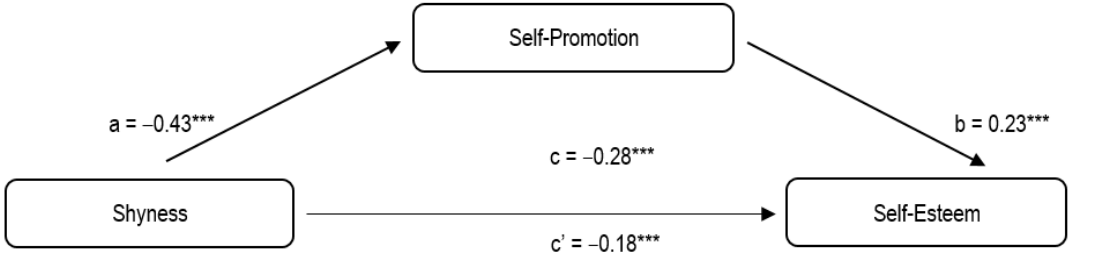
Figure 1. Results of mediation analysis of self-promotion in the relationship between shyness and self-esteem. *** p < 0.001.